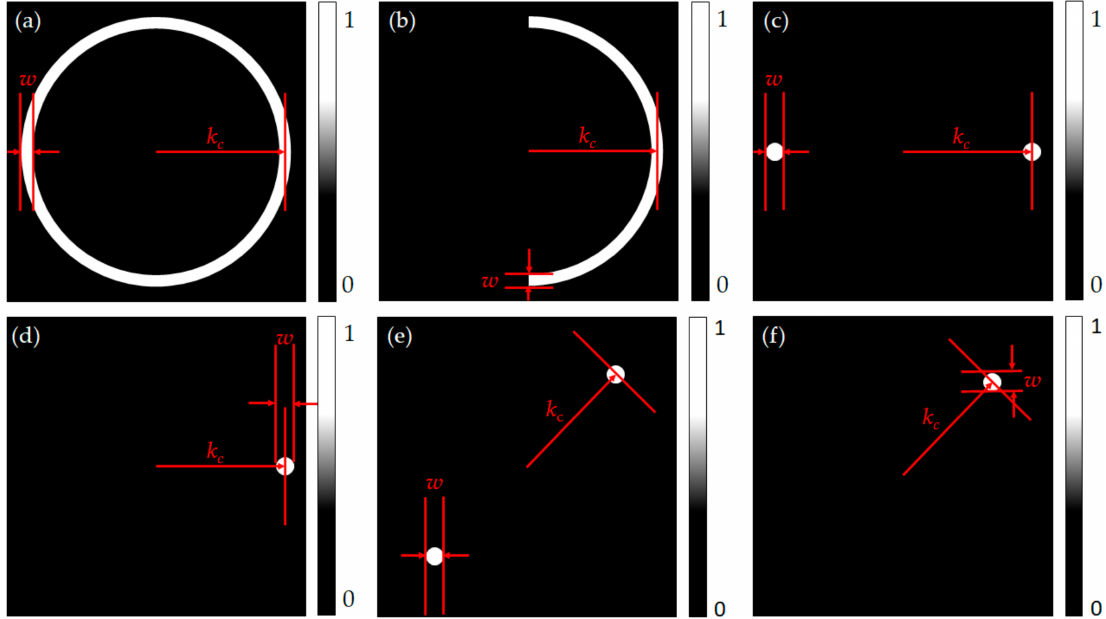
Figure 6. Shows the ( a ) annulus BFP aperture, ( b ) half annulus BFP aperture, ( c ) double-point BFP aperture, ( d ) single-point BFP aperture, ( e ) double-point BFP aperture with the azimuthal angle of 45 ◦ , and ( f ) single-point BFP aperture with the azimuthal angle of 45 ◦ . (1) Annulus BFP aperture reported by Tan et al. [24]; here, the responses of the micro- scope were simulated by defining the annulus aperture for the incident beam